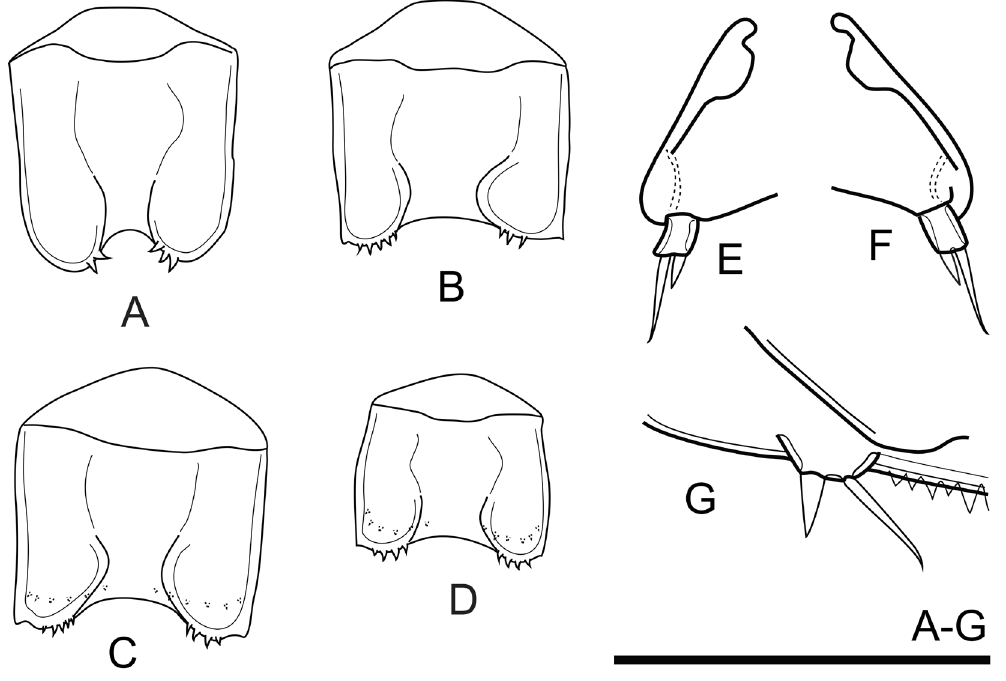
Fig. 9. Metacyclops sakaeratensis sp. nov., paratype , ♂ (A−D; ZMB 34230 slide No. 5123) and allotype, ♂ (E−G; ZMB 34230 slide No. 5121). A−D . Intercoxal sclerites of P1, P2, P3 and P4, respectively, frontal view. E−F . Right and left P5, respectively, ventral view. G . P6, lateral view. In C − D, the spinule row is on the caudal surface of intercoxal sclerite. Scale bar = 50